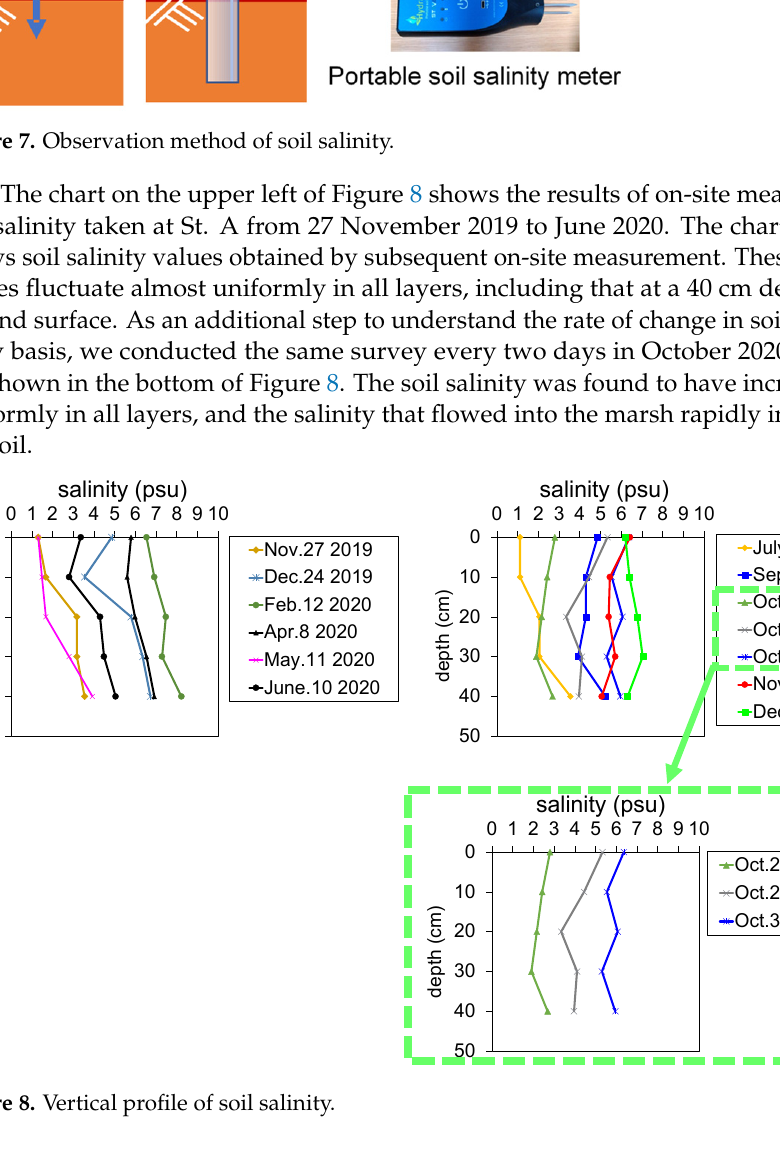
Figure 8. Vertical profile of soil salinity.